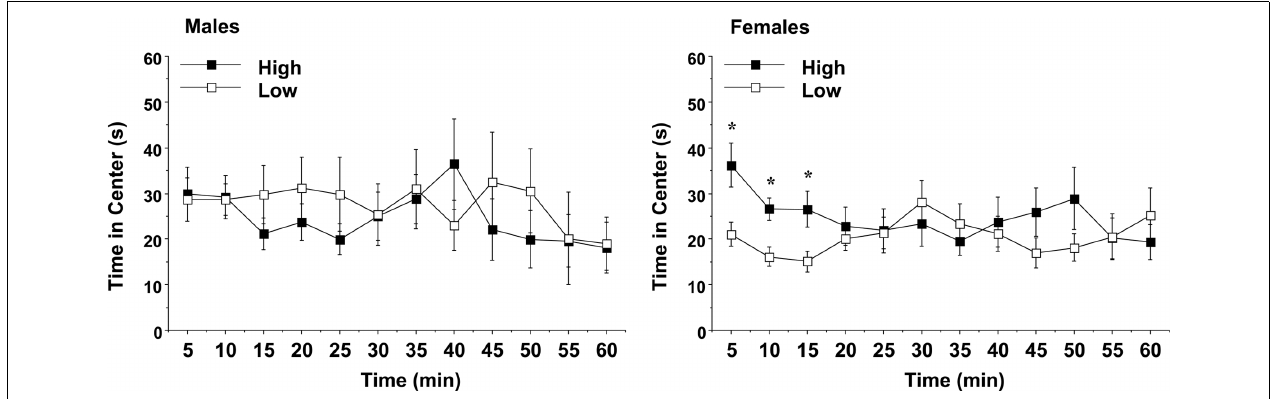
FIGURE 7 |Time spent in the center region of a novel environment during a 1-h session. Data shown are means ( ± SEM) for the first (Day 1) test.